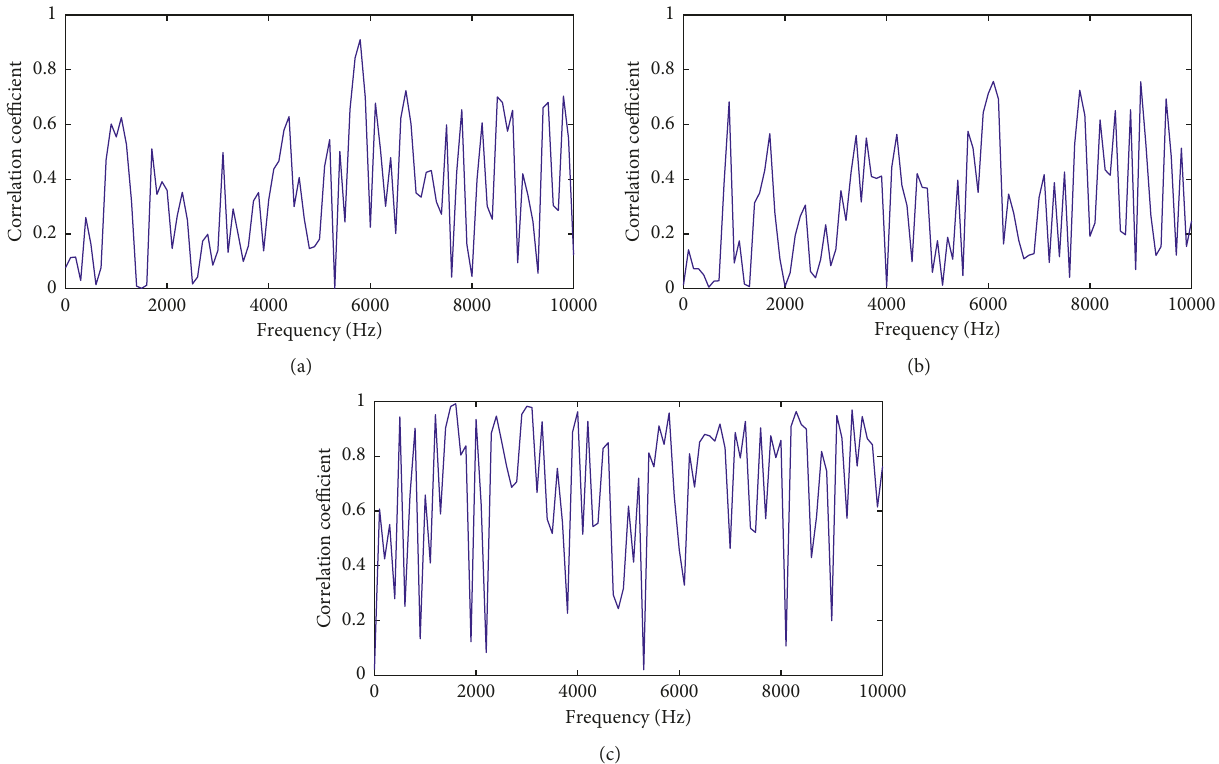
Figure 10: Correlation coefficient calculation results. (a) Main slap side correlation coefficient, (b) cylinder head top correlation coefficient, and (c) vice slap side correlation coefficient.